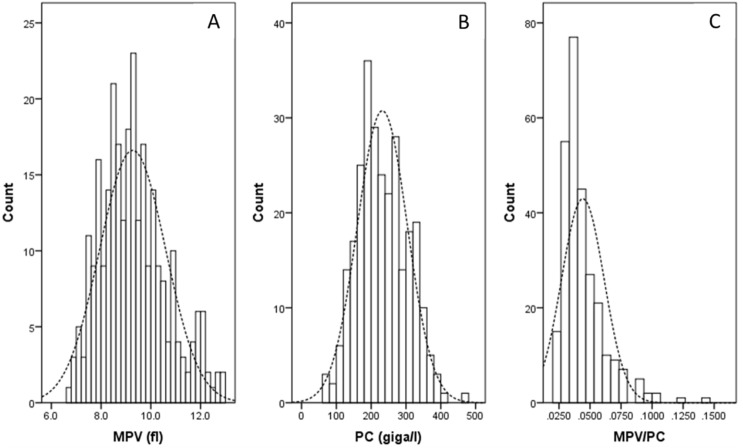
The histograms of the MPV (A), PC (B) and MPV/PC ratio (C).